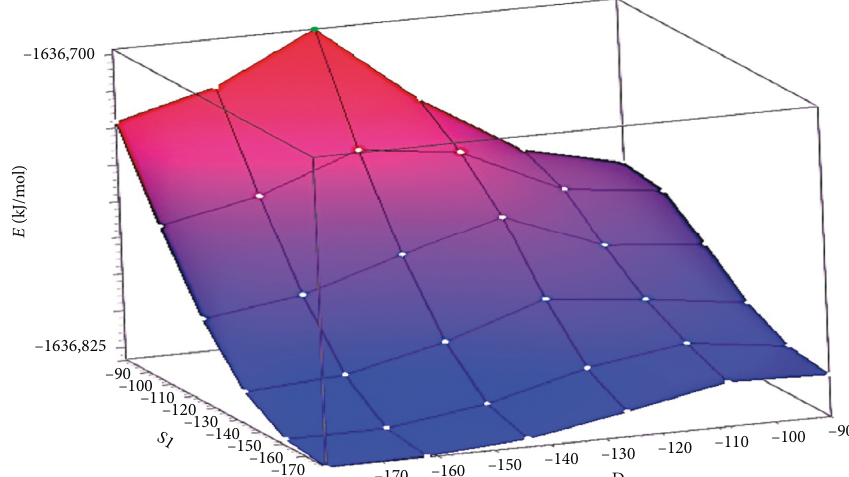
Figure 7: 3D Relaxed scan grid (of 36 nodes or scan steps “white points on the surface”) plotted by GaussView 6, showing an example of the total molecular electronic energy changes due to D-S1 simultaneous twisting in the S 1 state of BMN. Similar plots are obtained in case of D-S2 twisting (Figure 7). The most stable planar molecule is located in the front left corner of the plot, while the least stable is located in back upper red node [9, 10, 34] with twisting angles equal 144 for D-bond and 90 for S1-bond. Calculated using the CIS/6-31G(d, p) method of Gaussian 16